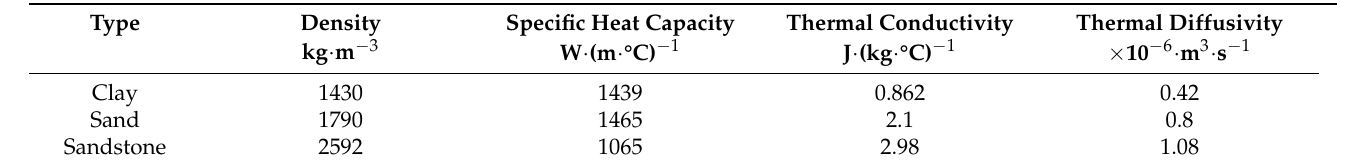
Table 4. Thermophysical parameters for three kinds of soils.